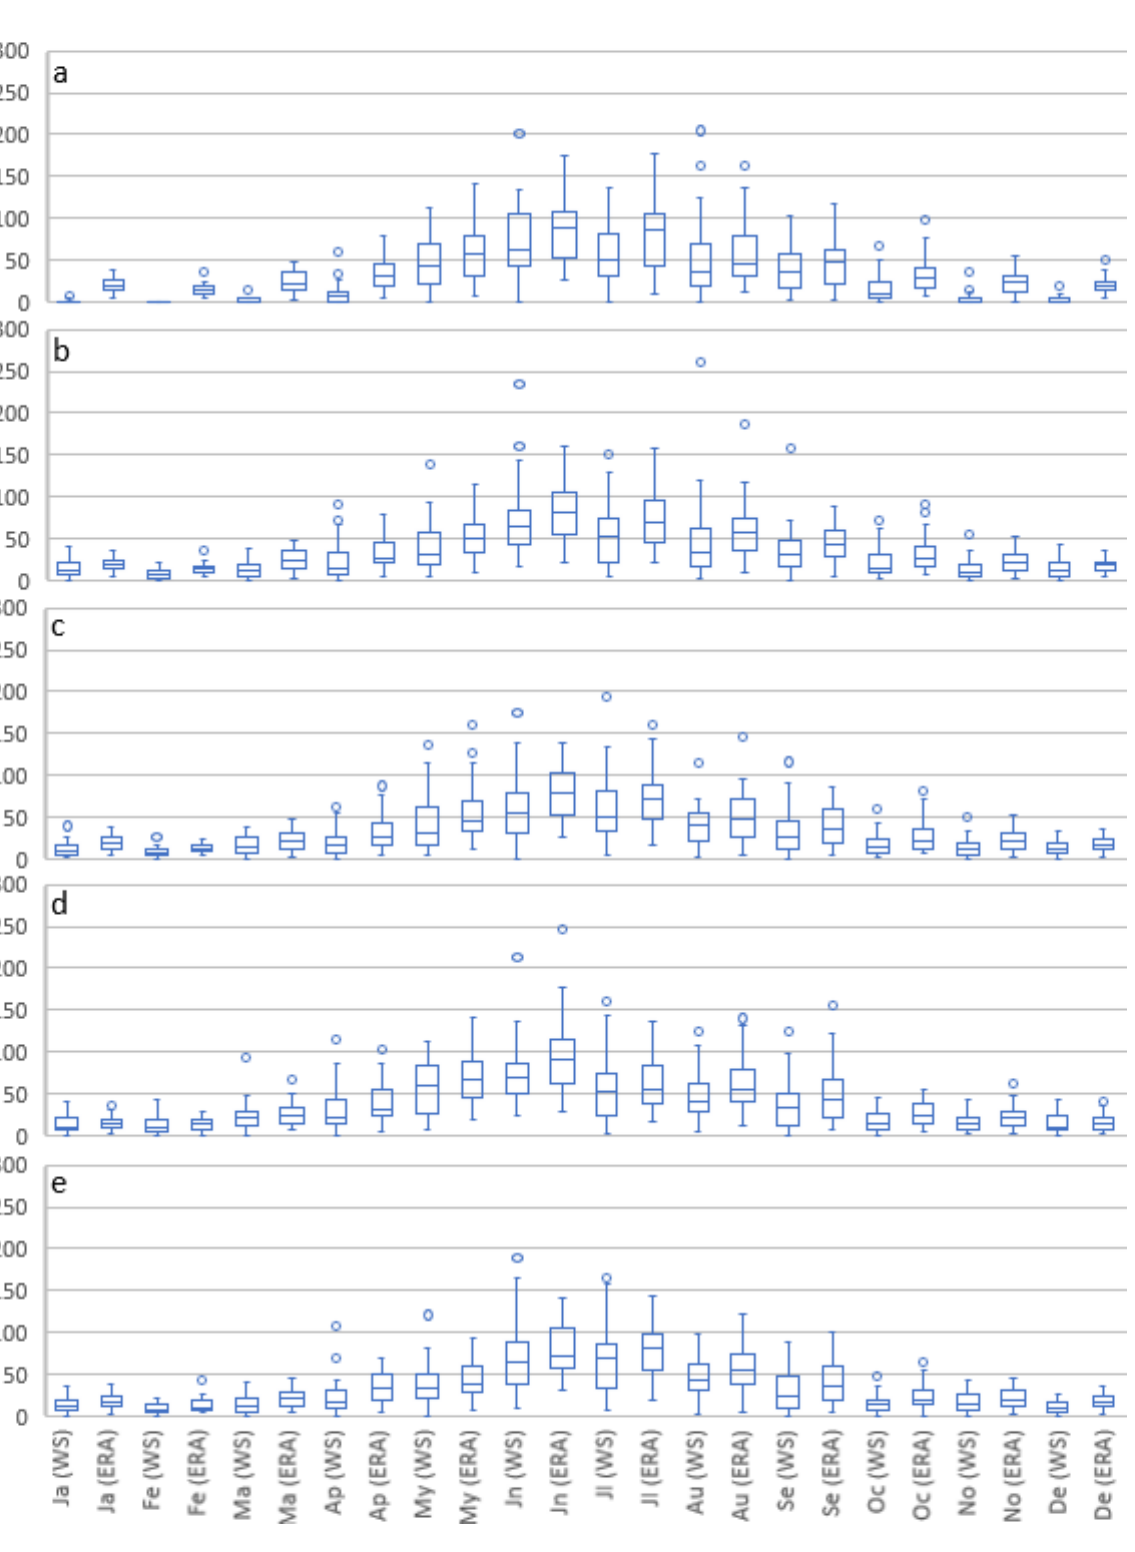
Figure 3. Boxplot of monthly precipitation (mm)—First the weather station (WS) data, followed by the ERA5-ECMWF (ERA) data (mm) in the Moist-Mixed Ecoregion for Buffalo ( a ), Last Mountain ( b ), Outlook ( c ), Queenstown ( d ), and Scott ( e ) in the period 1981–2019. The horizontal lines inside the boxes represent the median and the vertical lines at the top and bottom of the box represent the third and first quartiles, respectively. The ends of the vertical lines indicate the maximum (upper) and minimum (lower) values, and the isolated points show outliers.